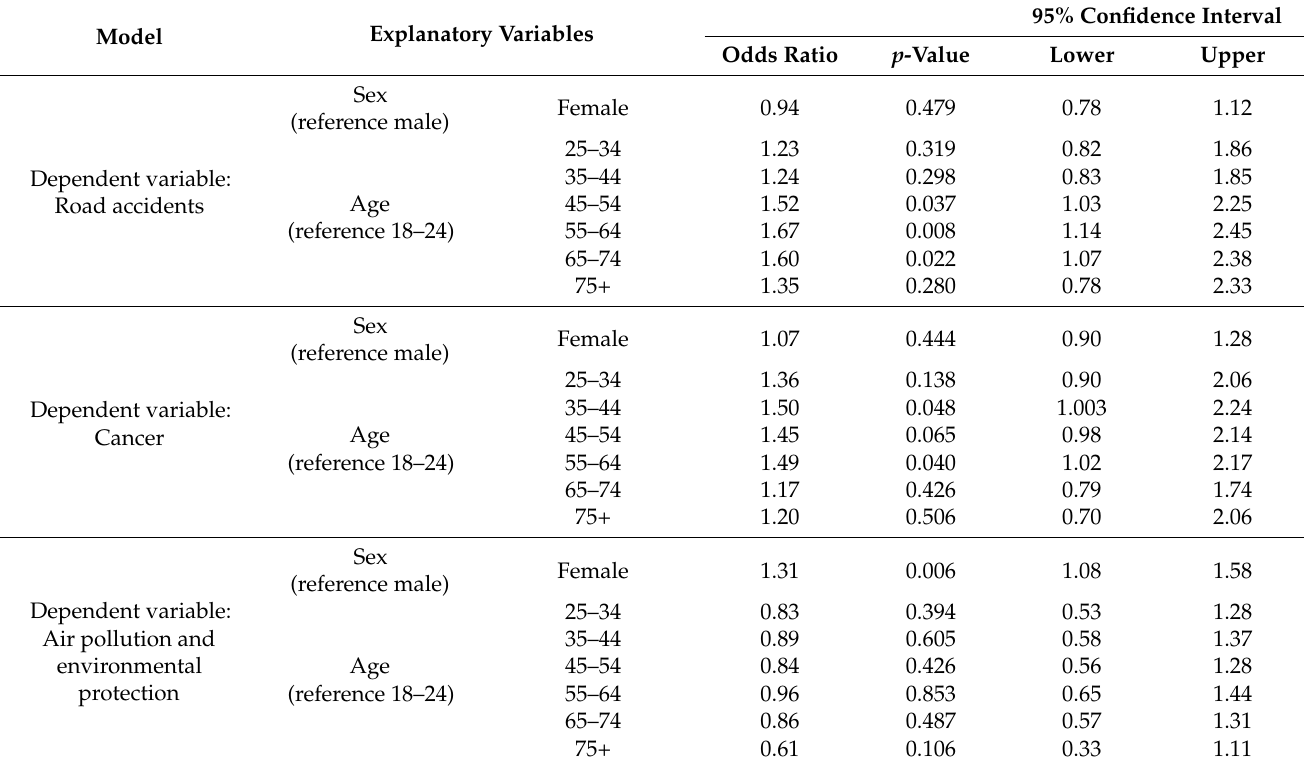
Table A3. Multivariate logistic regression models for the three most important public health